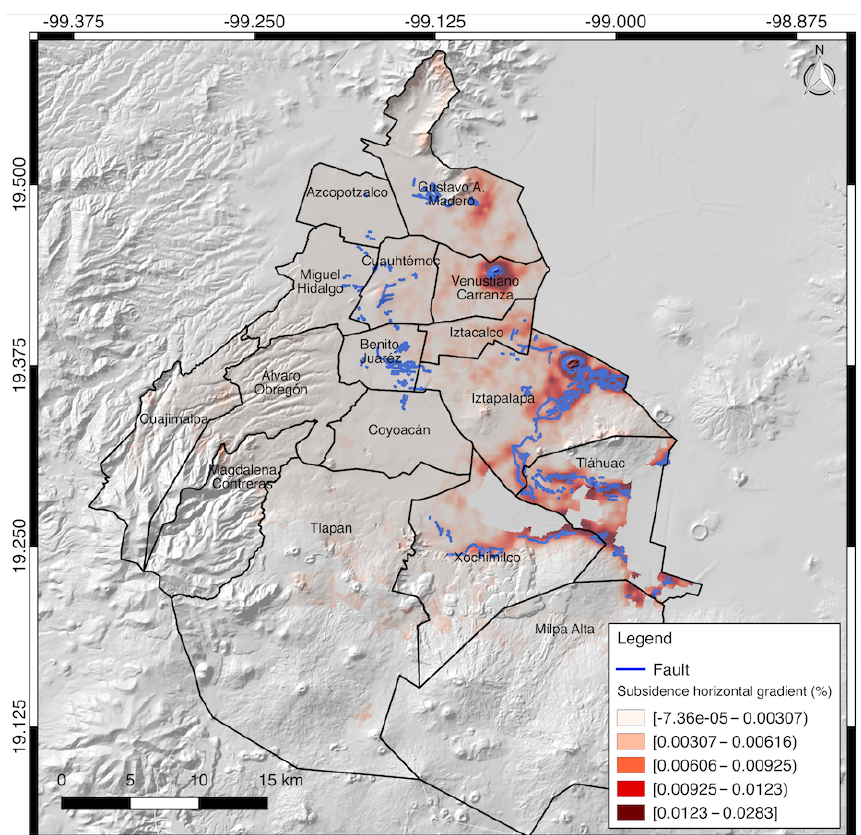
Figure 2. Horizontal subsidence gradient map for Mexico City derived from the Sentinel-1 velocity map (Fig. 1). Black lines show Mexico City’s municipalities. Blue lines show the field mapped subsidence associated faults after CENAPRED (2017). The shaded topographic base layer is taken from Continuo de Elevaciones Mexicano 3.0 © Instituto Nacional de Estadística Geografía e Informática (INEGI).